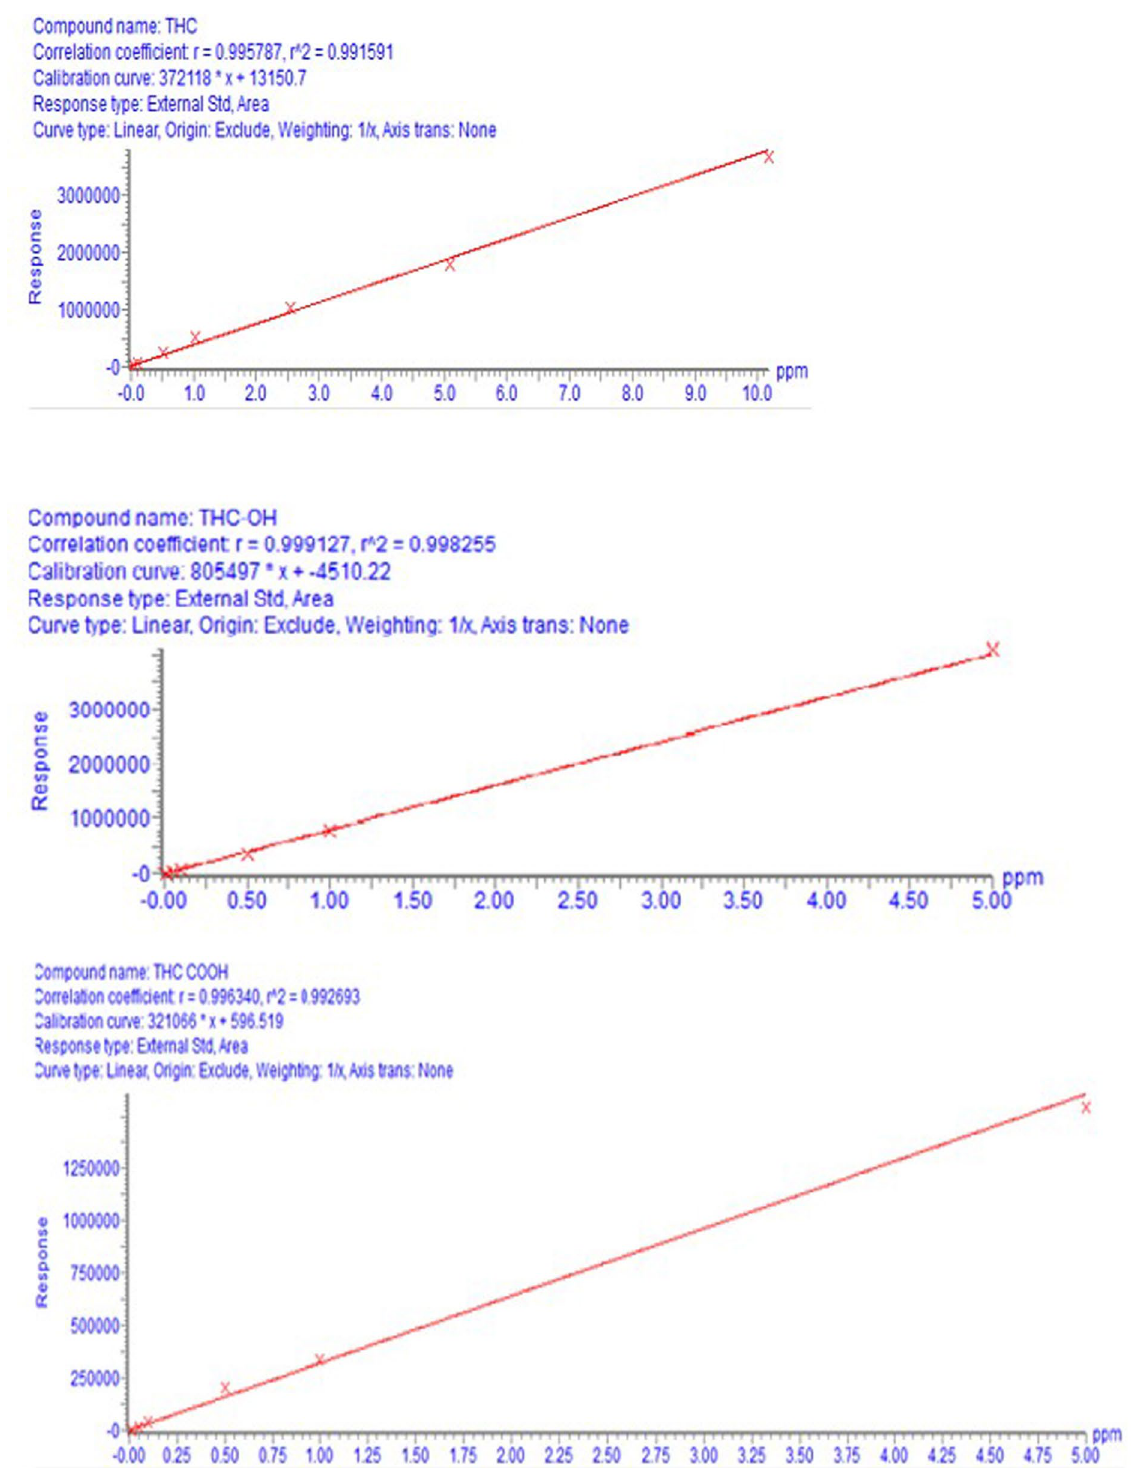
Fig. 2 Standard calibration curve for Δ 9 THC, THC‑OH, and